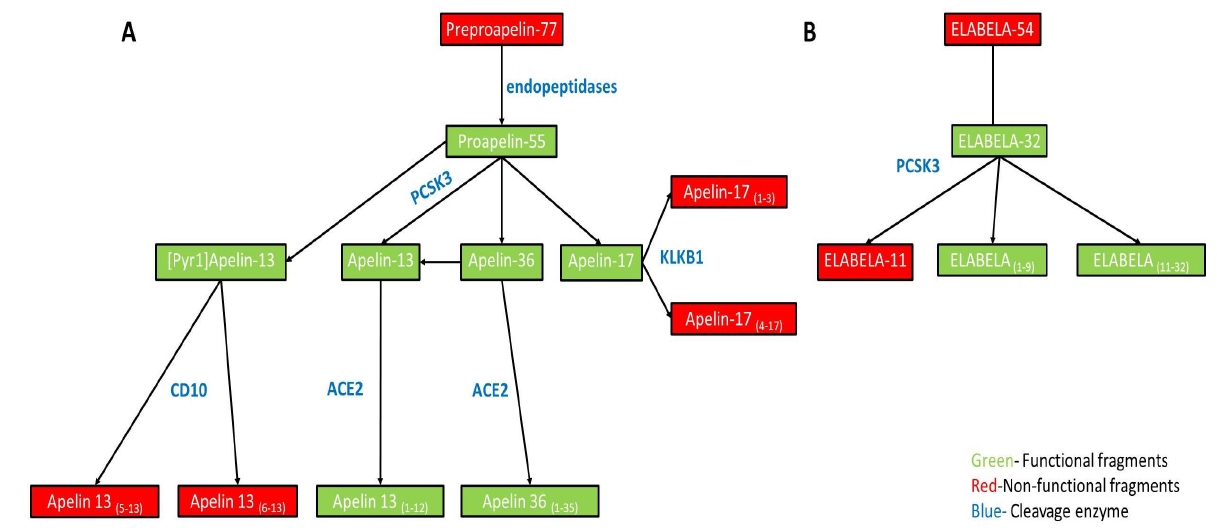
Figure 1. Enzymatic processing of Apelin/ELABELA. ( A ). The inactive pre-proapelin (77aa) is processed via endogenous endonucleases to Apelin-55, which can bind to APLNR. Apelin-55 can be additionally processed, generating four isoforms: Apelin-13, Apelin-17, Apelin-36, and [Pyr 1 ] apelin-13. The generation of Apelin-13 is achieved by PCSK3 (FURIN). All four isoforms are capable of binding to the APLNR. CD10 (Neprilysin) is capable of inactivating [Pyr 1 ] apelin-13, creating two inactive Apelin-13 isoforms (5–13aa and 6–13aa). On the other hand, Angiotensin-converting enzyme 2 (ACE2) converts Apelin-13 and Apelin-36 to active forms, Apelin-13 (1–12) and Apelin-32 (1–35) . ( B ). ELABELA gene codes for a non-functional 54aa-long pro-protein, which generates an active 32aa- long protein upon processing. ELABELA-32 can generate three fragments, ELABELA-11, an inactive form, generated with the help of PCSK3, and two functional ones, ELABELA (1–9) and (11–32) , with the activity of unknown proteases. Abbreviations: PCSK3, proprotein convertases subtilisin/kexin type; CD10, Neprilysin; ACE2, Angiotensin Converting enzyme-2; KLKB1,